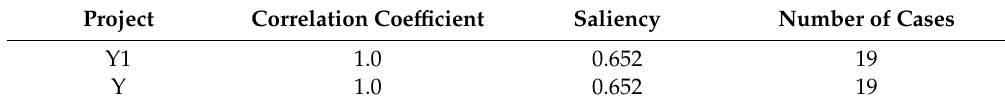
Table 2. The p rediction results of the linear regression equation. Table 4. Variance analysis results of regression